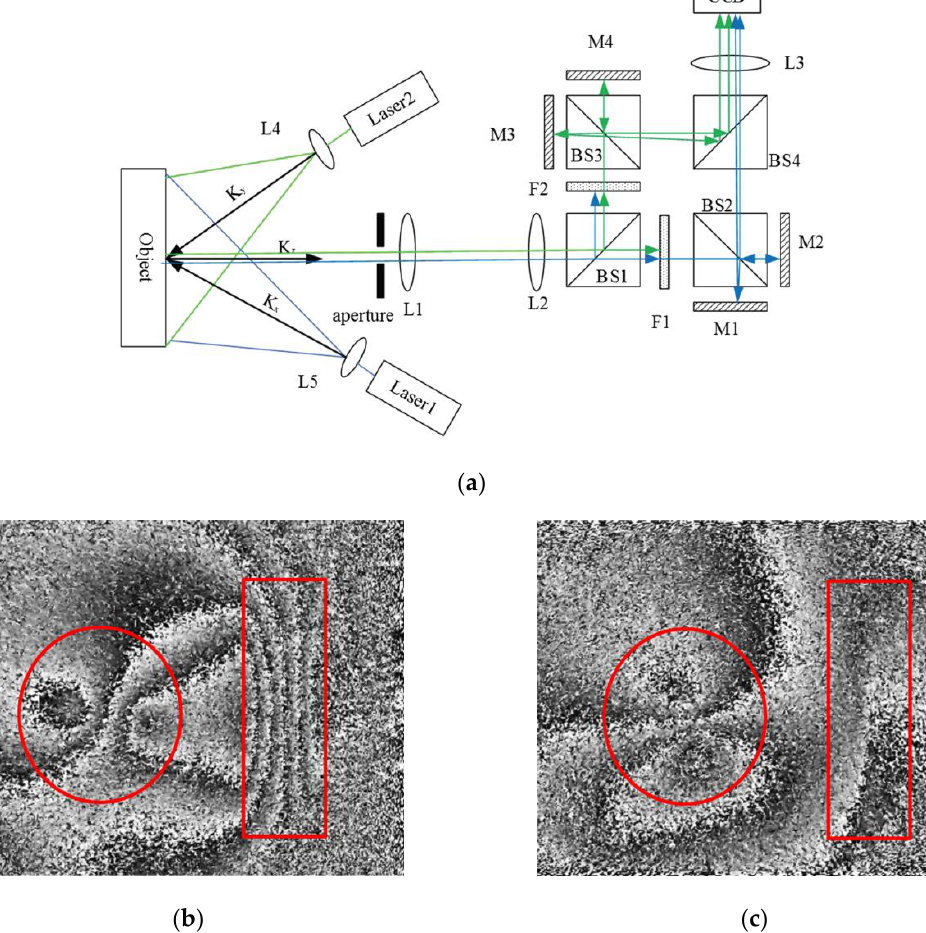
Figure 11. ( a ) The dual-shearing direction SPS-DS system; ( b ) measurement result of circular flaw and bar flaw in x direction; ( c ) measurement result of circular flaw and bar flaw in y direction.